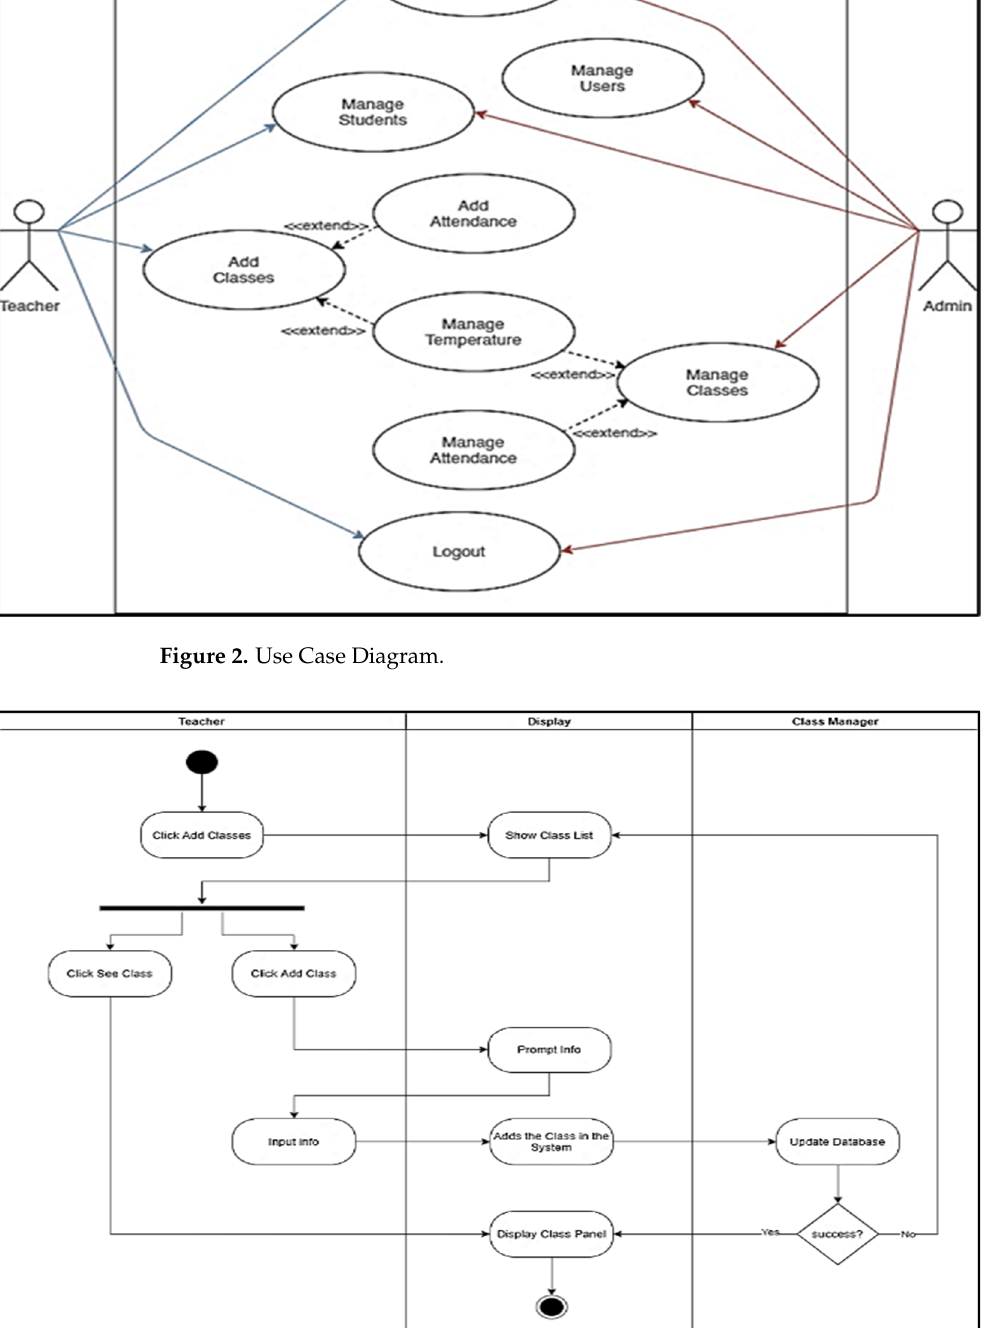
Figure 3. Activity Diagram for Add Classes Use Case.